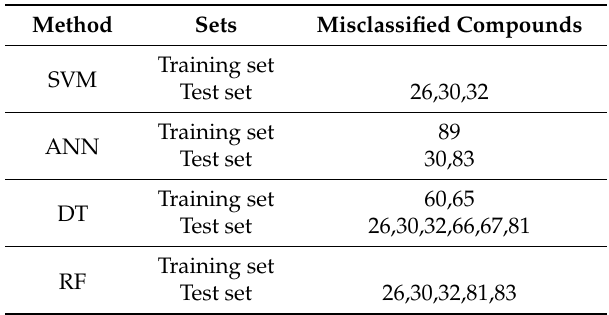
Table 4. Misclassified samples by SVM, ANN, DT, and